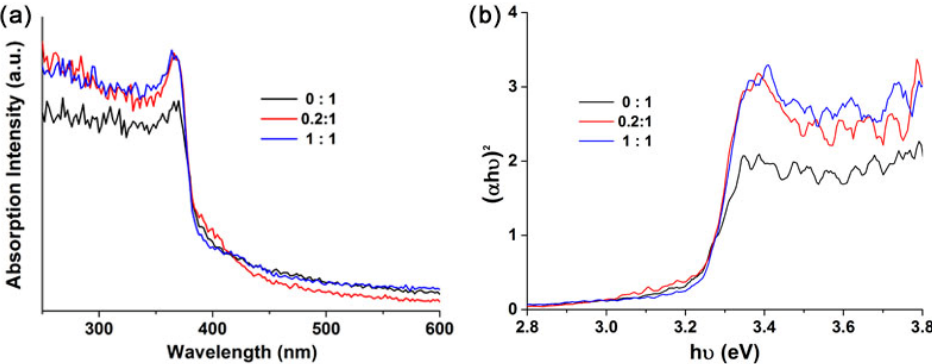
Figure 6. ( a ) Ultraviolet (UV) ‐ Vis absorbance spectrums of the 2D ZnO IO films with different CA/ZA molar ratios; ( b ) Corresponding ( α h ν ) 2 ‐ h ν curve.